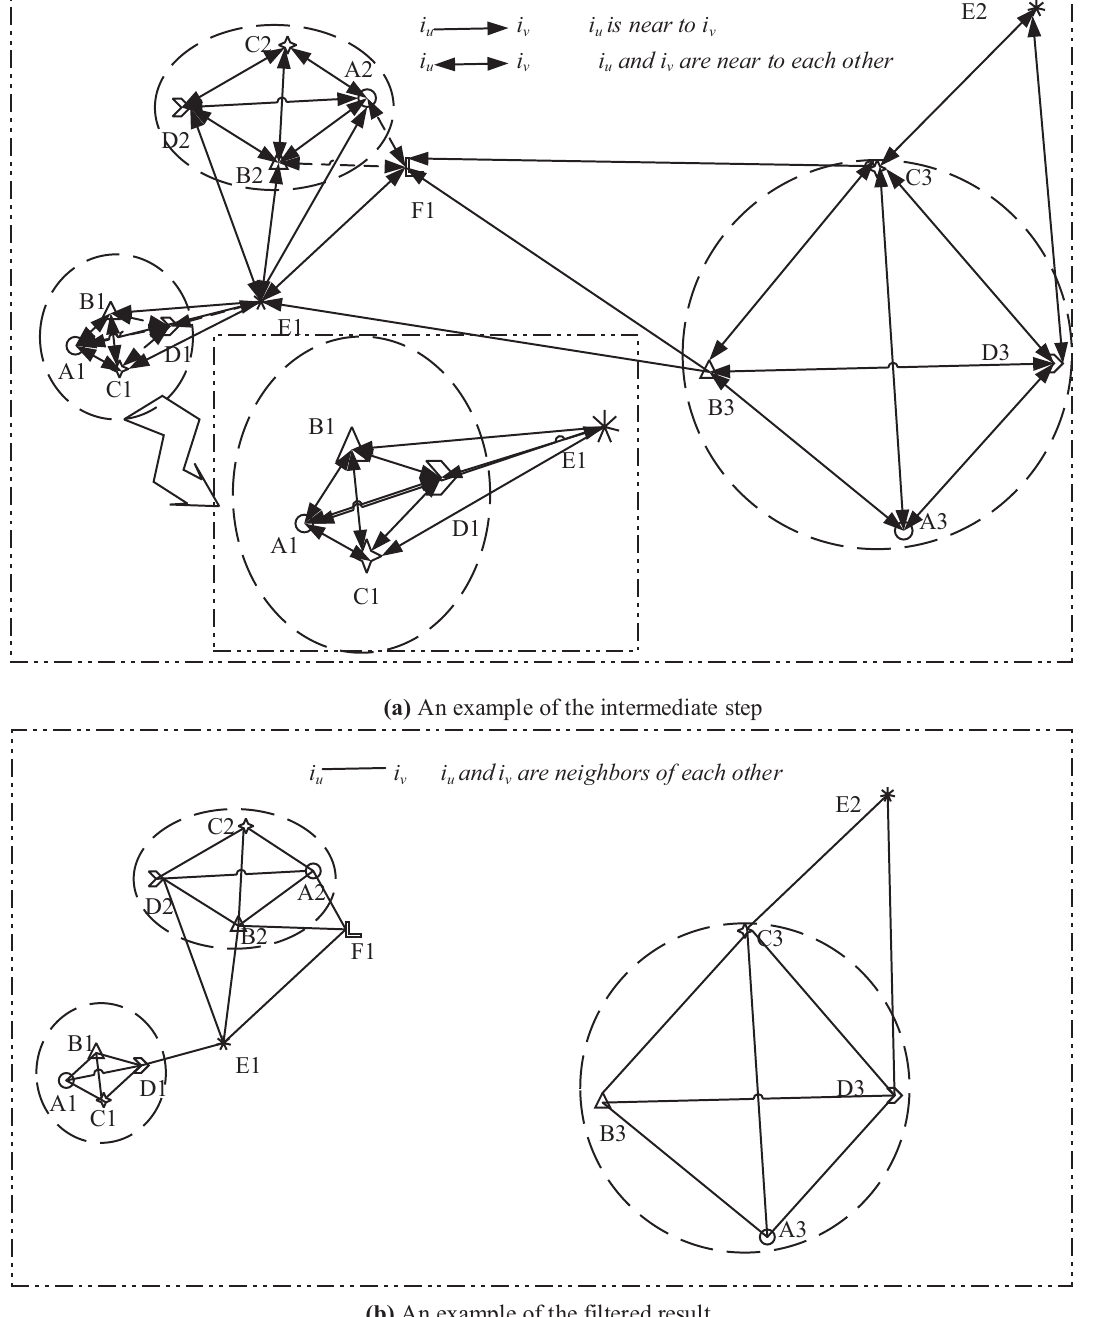
Figure 2. This is an improved neighbor relationship graph of Figure 1. ( a ) Directed neighbor rela- tionships are generated on the nearest neighbors and the given coefficient α = 2. ( b ) The digraph is converted into an undigraph on mutual neighbors . Luckily, it is adaptable to the different distribution